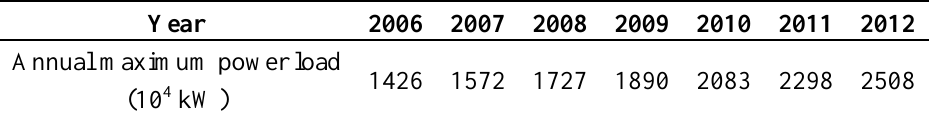
Table 3. Power load forecasting result of the proposed